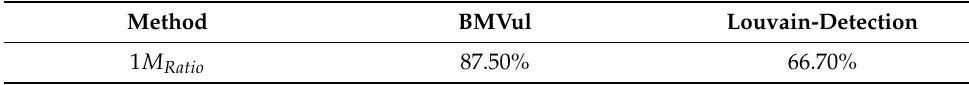
Table 6. Evaluation of 1 M Ratio